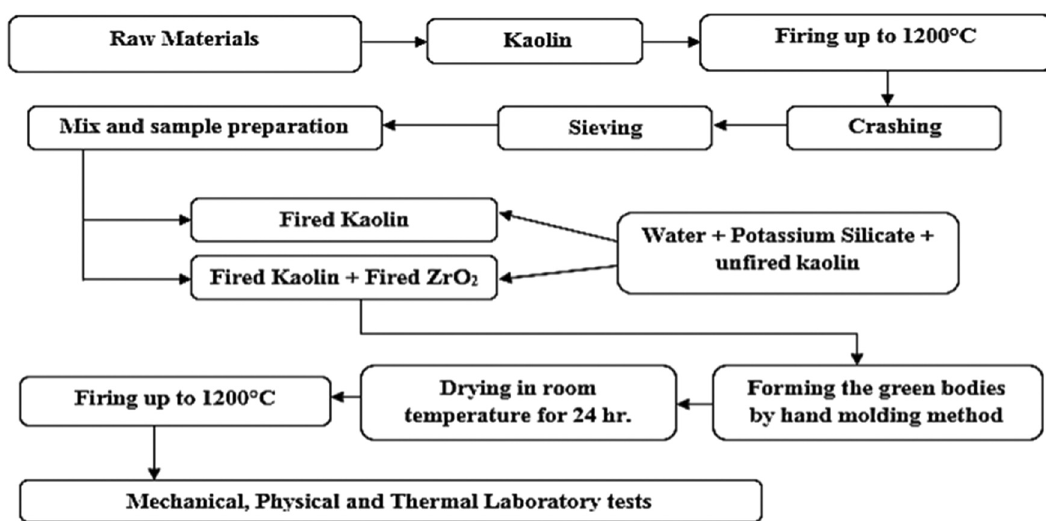
Figure 1: Block diagram of the present work.